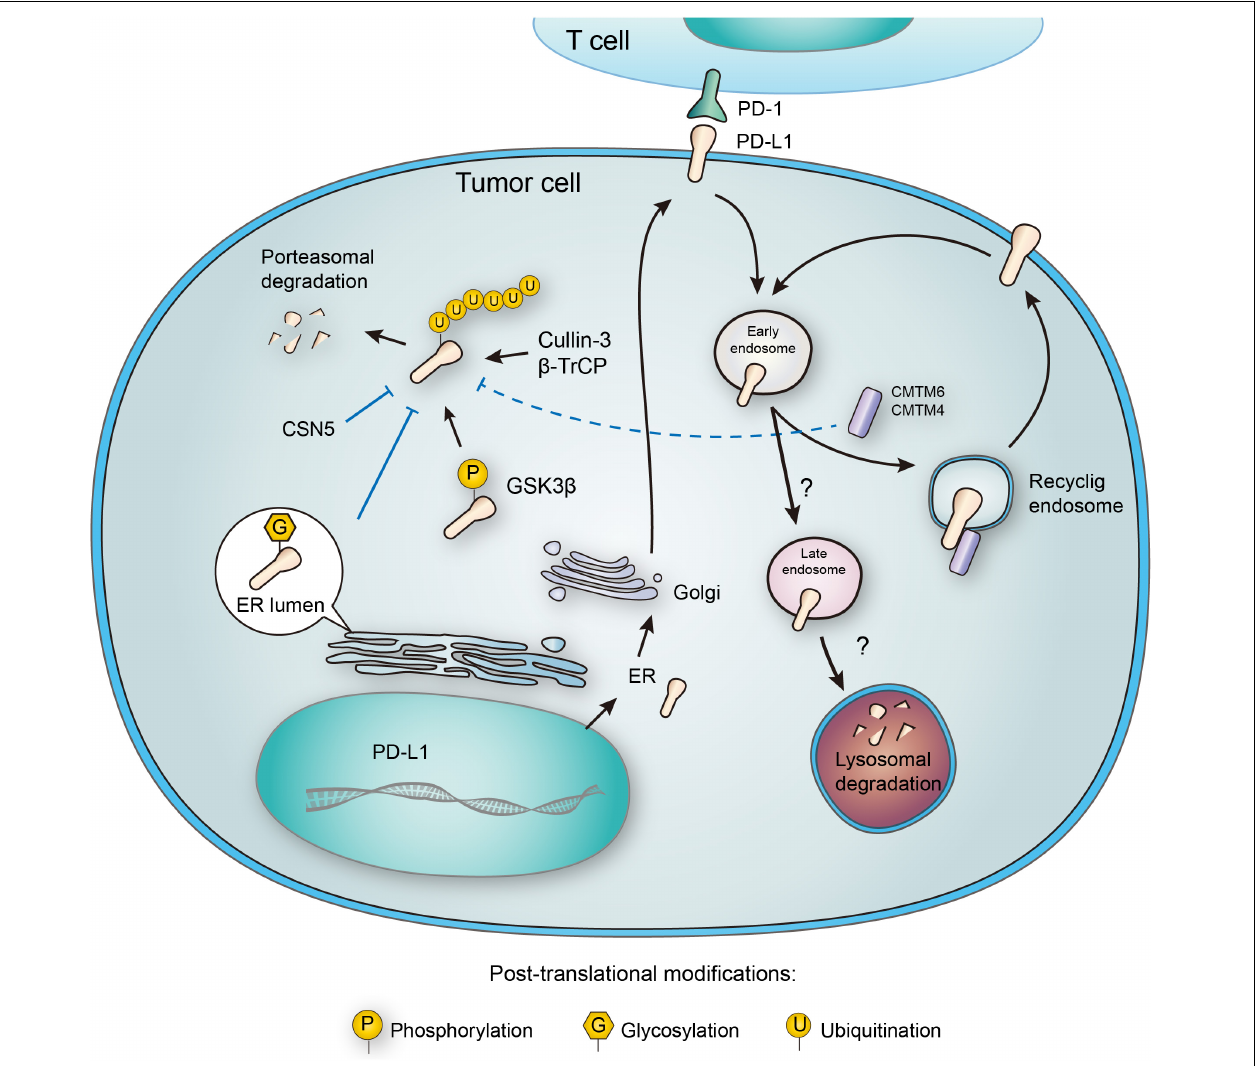
FIGURE 3 | Post-translational modifications and subcellular transportation of PD-L1. As a membrane protein, PD-L1 is extensively modified after its translation. N -glycosylation of PD-L1 extracellular domain occurs in the lumen of endoplasmic reticulum (ER), and this modification facilitates the interaction of PD-L1 with lipid membrane. Glycosylation also inhibits phosphorylation by GSK3 β , and thereby blocking the ubiquitination by β -TrCP. Deubiquitination by CSN5 also protects PD-L1 from proteasomal degradation. In addition, PD-L1 may also be destructed in lysosome, and this process relies on a series of subcellular transportations from cell membrane to early endosome, late endosome, and finally to lysosome. However, CMTM6 has been found to promote PD-L1 transportation to recycling endosome, causing decreased distribution to late endosome and lysosome. Interestingly, CMTM6 and its homolog CMTM4 may also stabilize PD-L1 by suppressing its